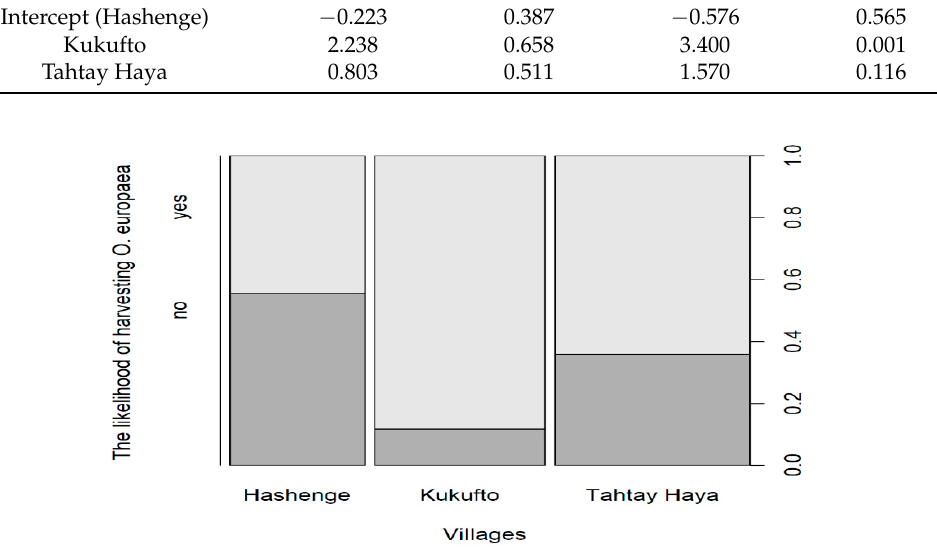
Figure 5. The likelihood of O. europaea (Wall. ex G. Don) Cif. wood being harvested from the forest by the respondents living in the three villages adjacent to Hugumburda forest.